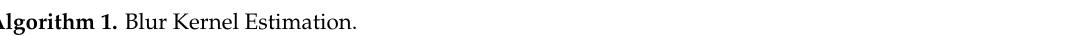
Algorithm 1. Blur Kernel Estimation.